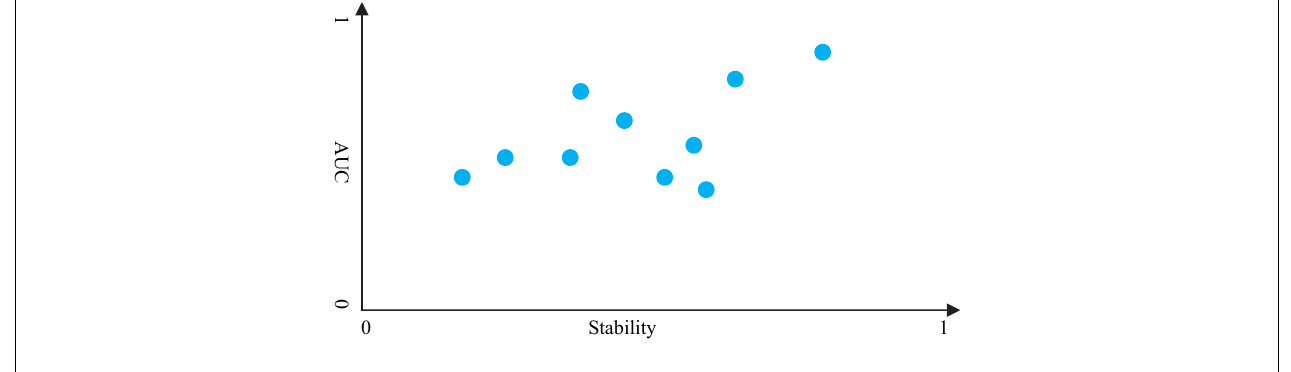
FIGURE 3 | Decision graph for feature selection.